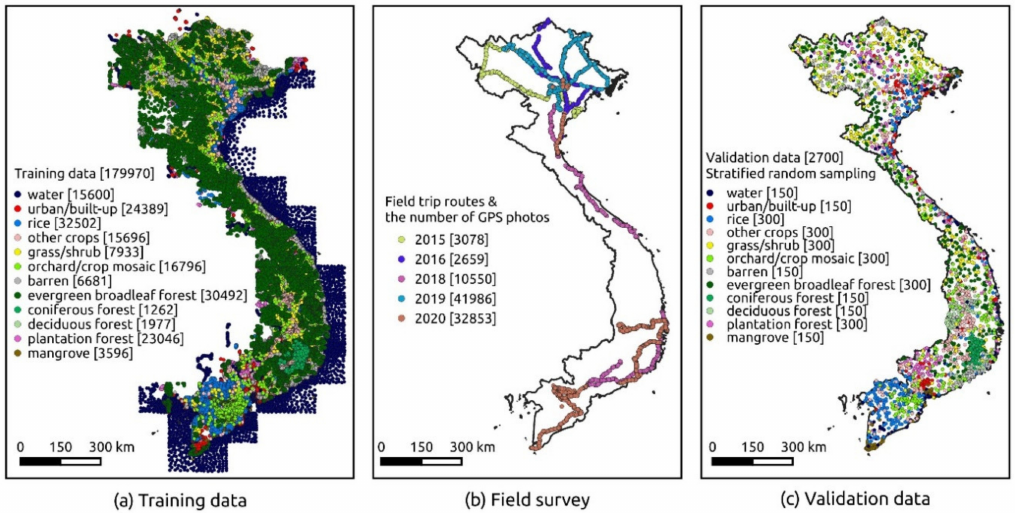
Figure 3. Distribution and quantity of reference data. ( a ) Distribution and quantity of training data; ( b ) Distribution and quantity of field survey data; ( c ) Distribution and quantity of validation